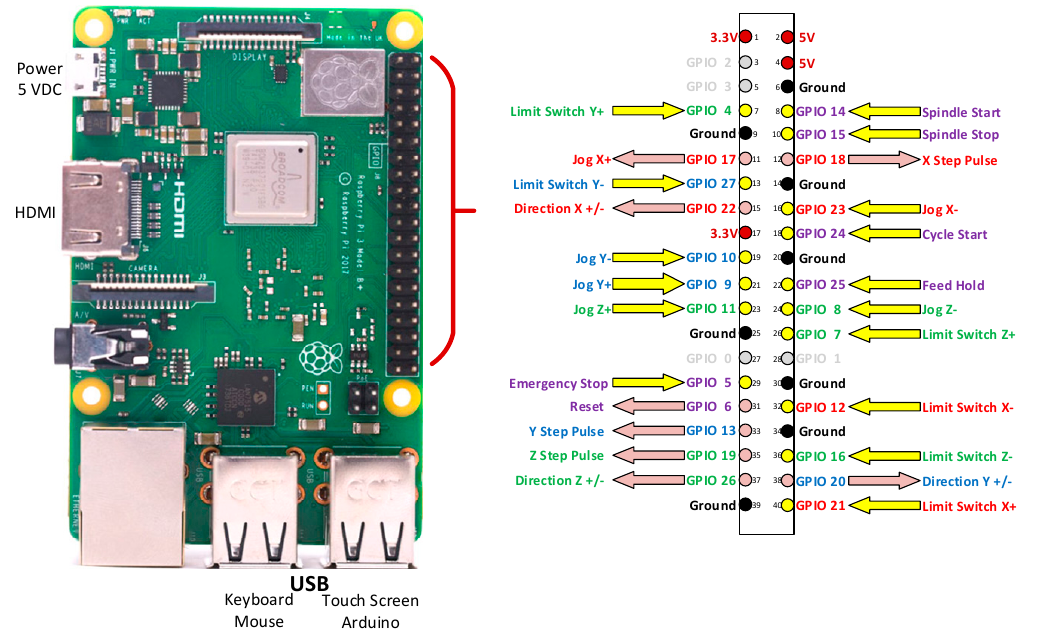
Figure 4. Raspberry Pi input–output connections.